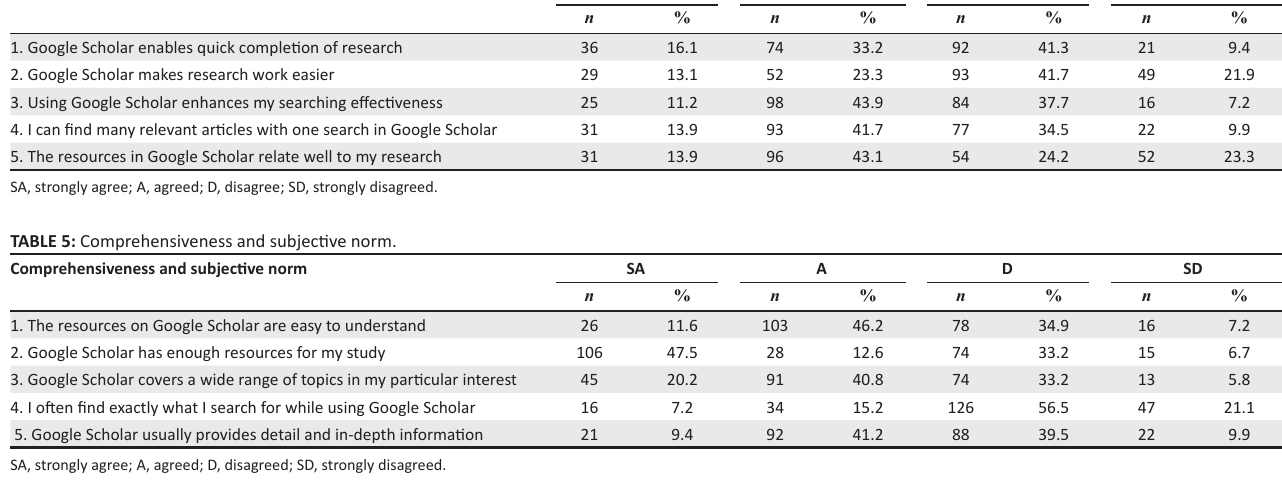
TABLE 4: Perceived usefulness of Google Scholar. Perceived